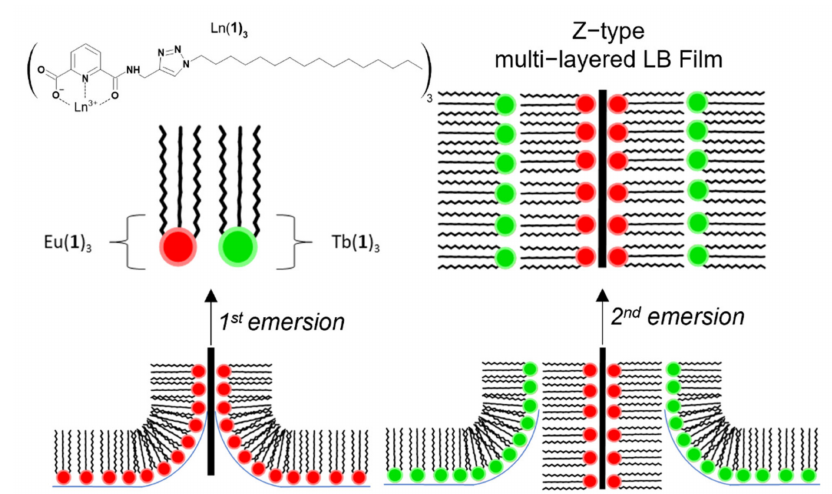
Figure 1. Diagram showing ligand 1 and corresponding Ln( 1 ) 3 complexes (where Ln = Eu 3+ , Tb 3+, and Dy 3+ ), which has been utilised to fabricate multilayered Z - type mixed LB films. The figure represents an example of an Eu( 1 ) 3 :Tb( 1 ) 3 dual-layered film, with an initial emersion of Eu( 1 ) 3 , resulting in a monolayer Eu( 1 ) 3 film, followed by a 2nd emersion of Tb( 1 ) 3